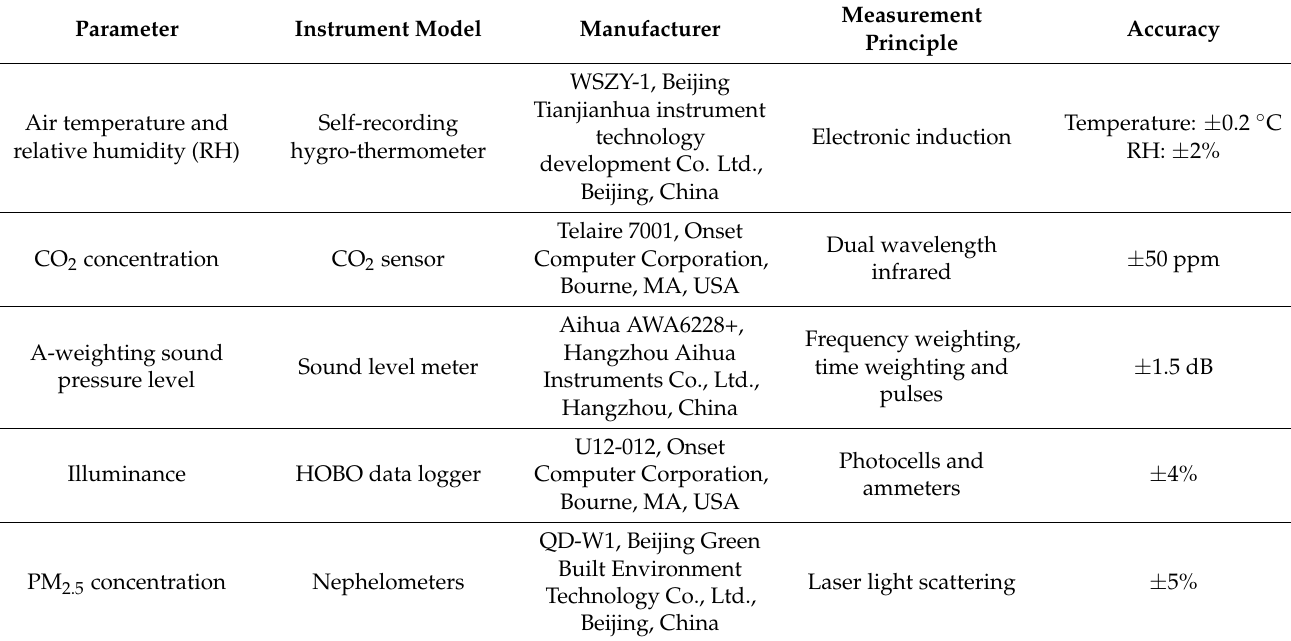
Table 1. Measuring parameters and